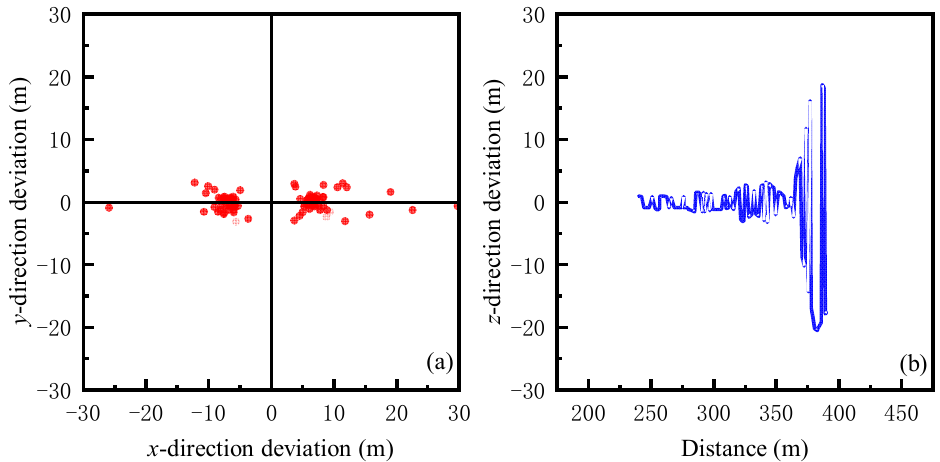
Figure 10. The SGJM positioning result error: ( a ) Positioning error in x and y directions; ( b ) z -directional positioning error.